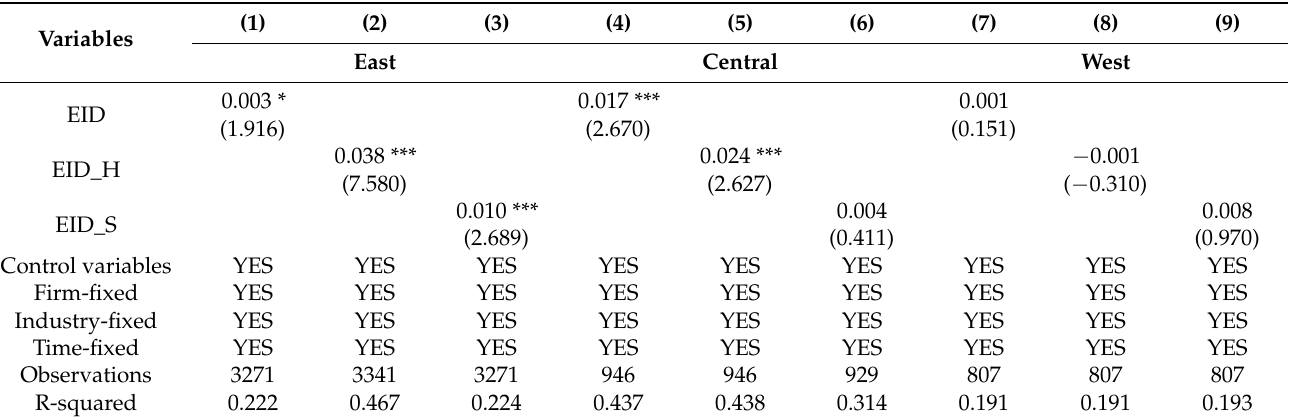
Table 7. Heterogeneity analysis: regional